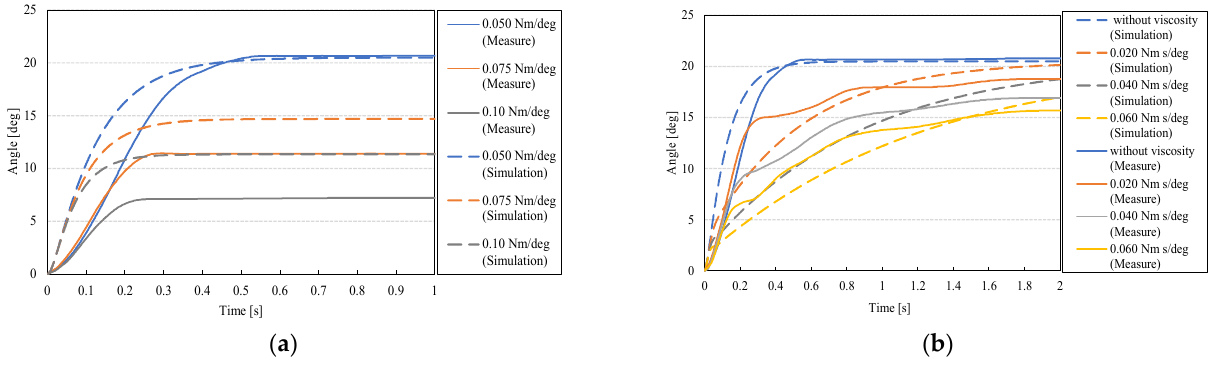
Figure 18. Simulation and measurement results of static load experiment. ( a ) Result of angle (joint stiffness). ( b ) Result of angle (joint viscosity).